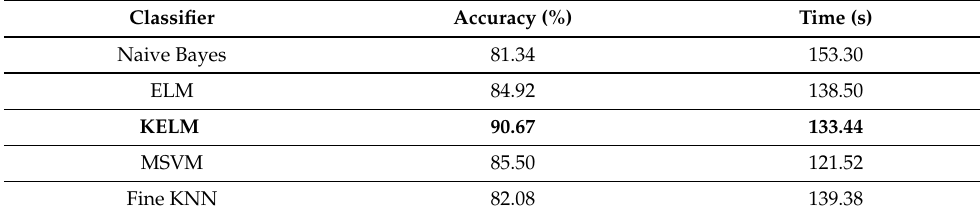
Table 3. Results of existing approaches on the HAM1000